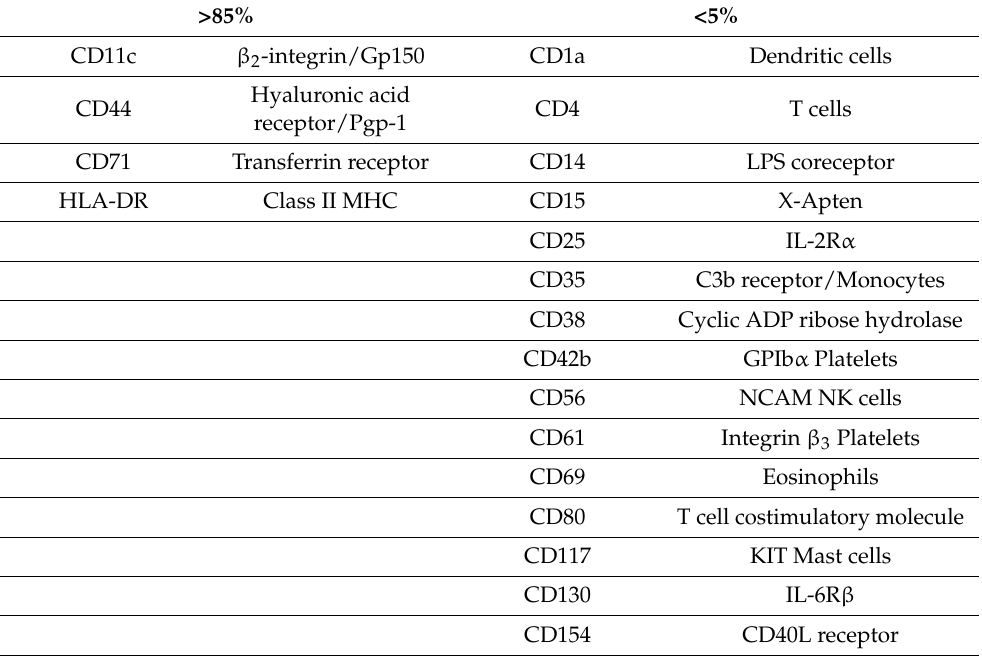
Table 2. Common surface marker expression on LDMs and HDMs *.